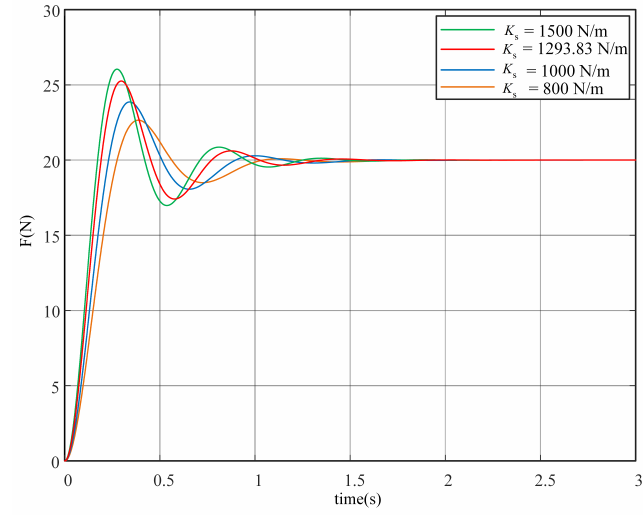
Figure 12. Robustness test for FO-impedance controller.